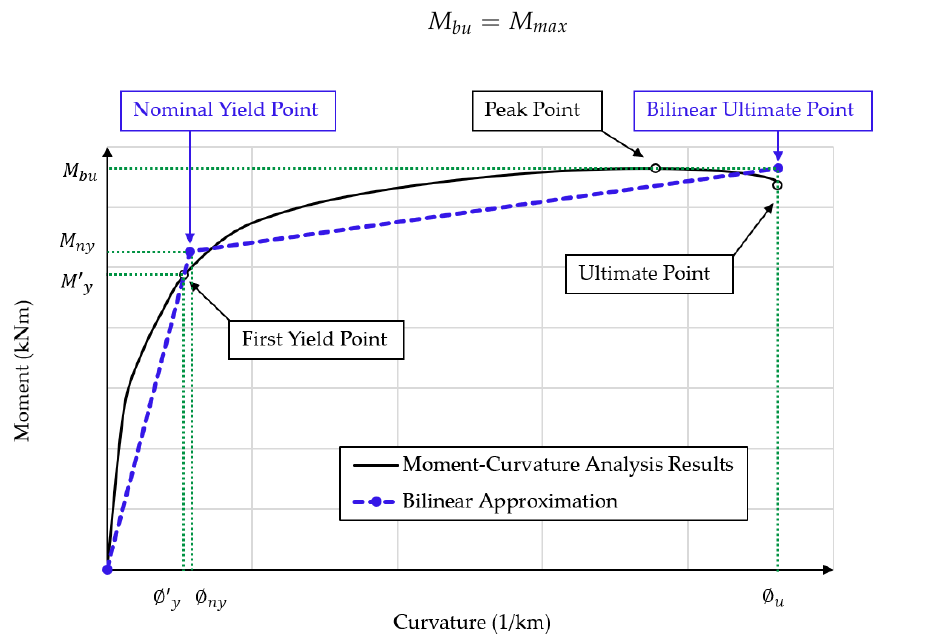
Table 3. Material strain limits for moment–curvature analyses of lightly reinforced load-bearing precast walls.